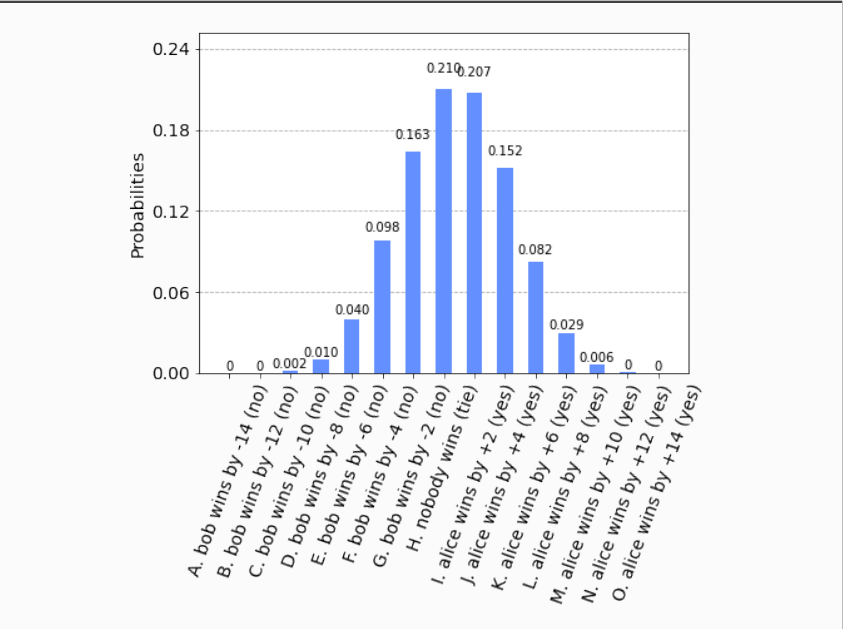
Figure 4. The possible outcomes and their probabilities for the same maximum free will radius 1. In this case all representatives from both parties behave as independent legislators.